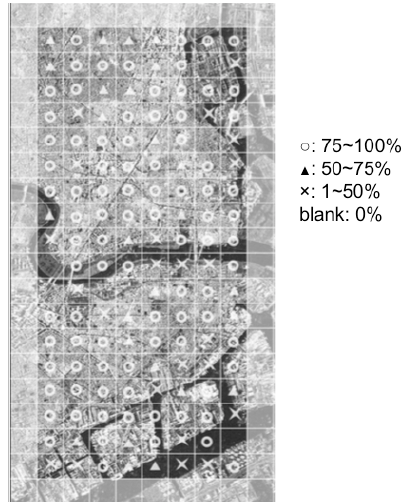
Figure 4. 200 sub-areas divided in the study site. The mark shows the ratio of “Detect” for 20 pairs of data for each sub- area Table 2. Difference of the displacement around